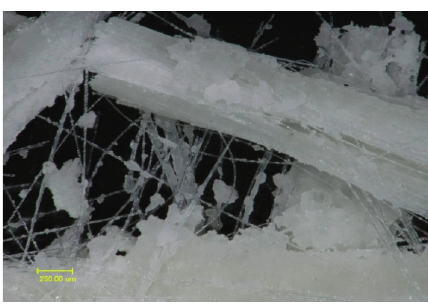
Figure 14: Randomly arranged fibres formed by bonded bundles associated with mineral filler and